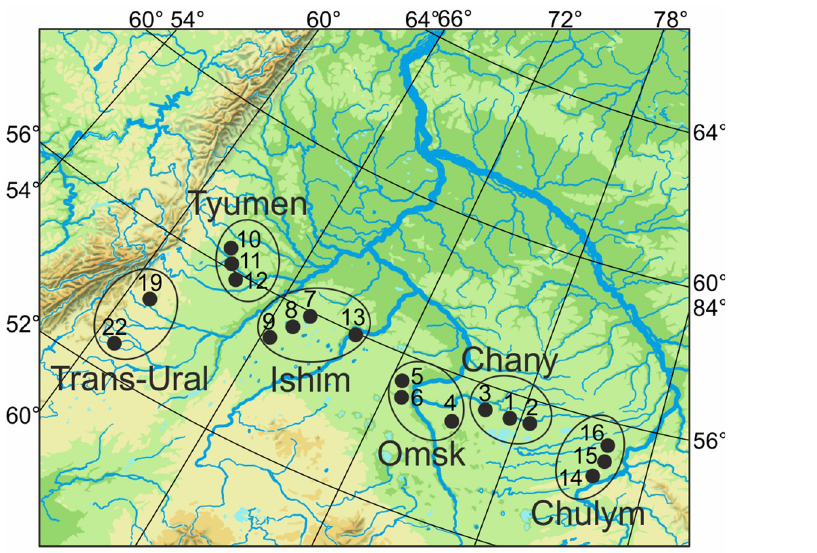
Fig 1. Map of Lymantria dispar collection in 2015–2016